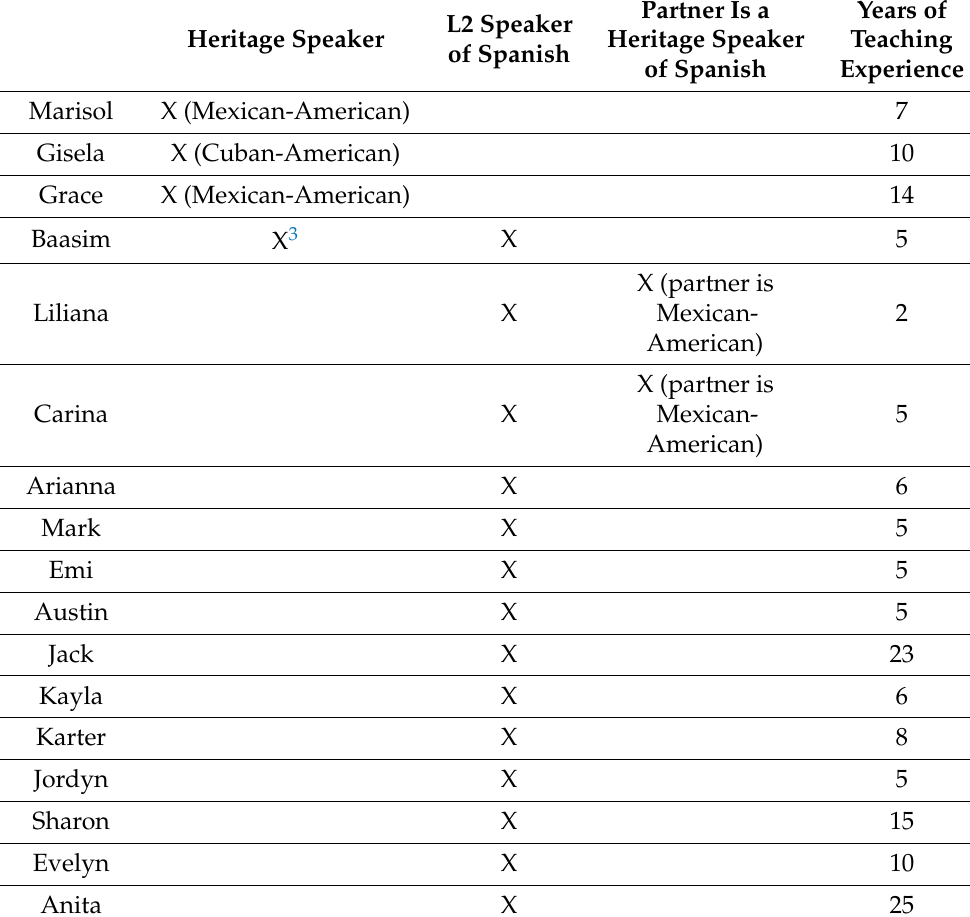
Table 3. Demographic characteristics of study participants 2